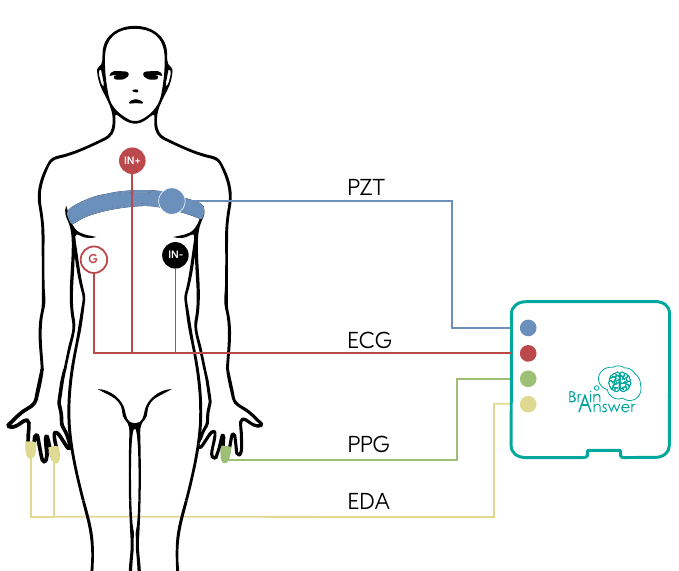
Figure 2. Schematic of the placement for the ECG (red) electrodes, and PZT (blue), PPG (green), and EDA (yellow) sensors.